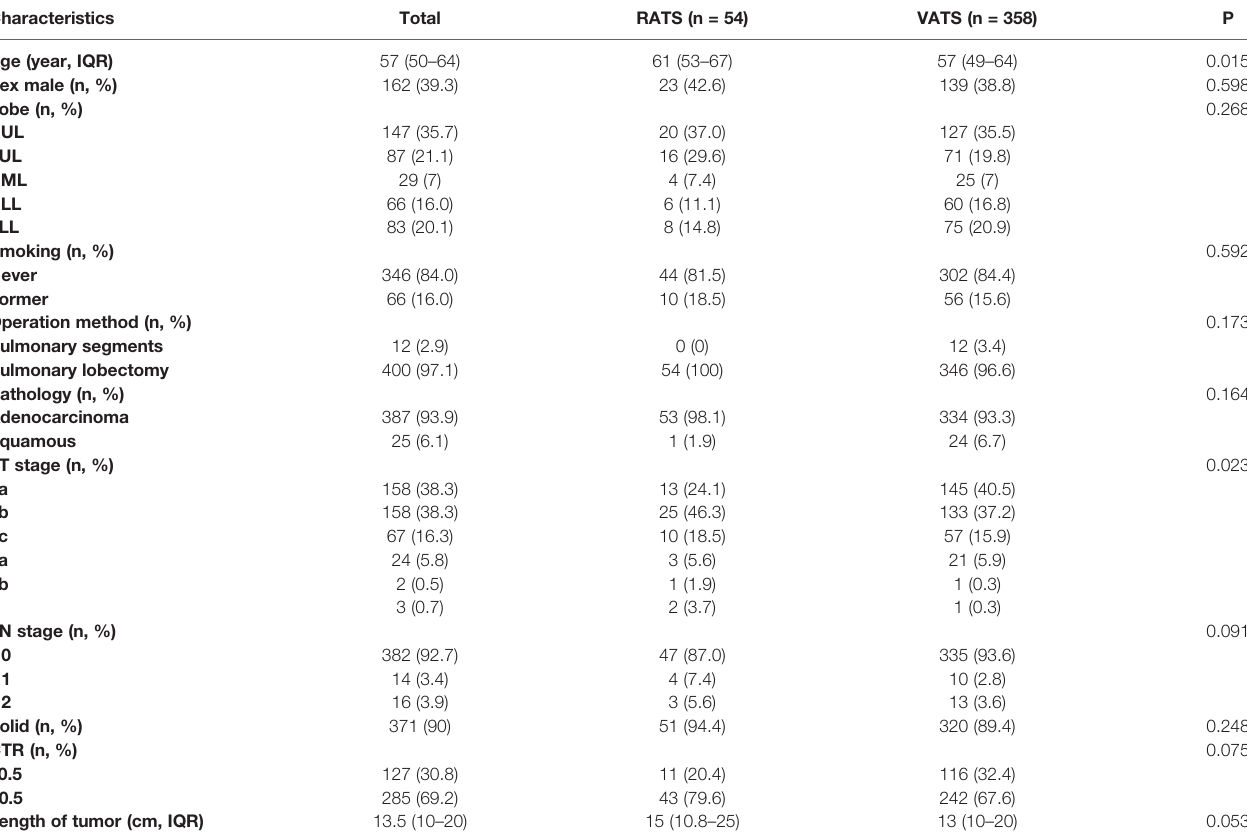
TABLE 1 | Patient characteristics in the unmatched cohort (N = 412).